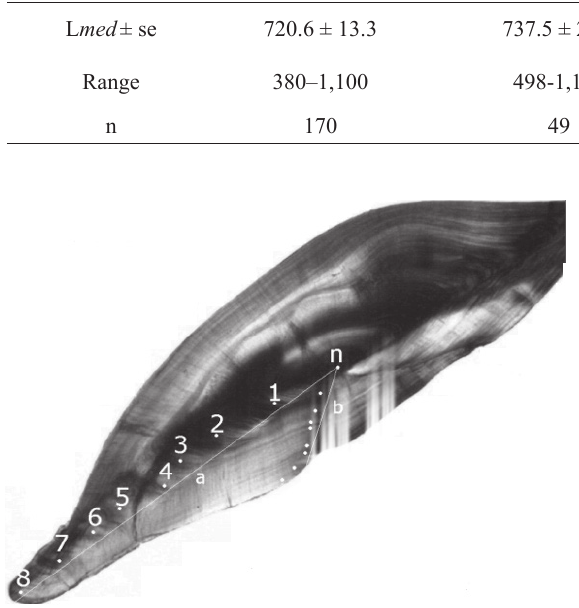
Figure 1 - Transversal section (0.3 mm width) of otolith from a pink cusk-eel Genypterus brasiliensis (female, 946 mm, 8 annuli, caught in October 2002 south of Rio de Janeiro, Brazil, around 300 m depth) observed through reflected light and 16 x.